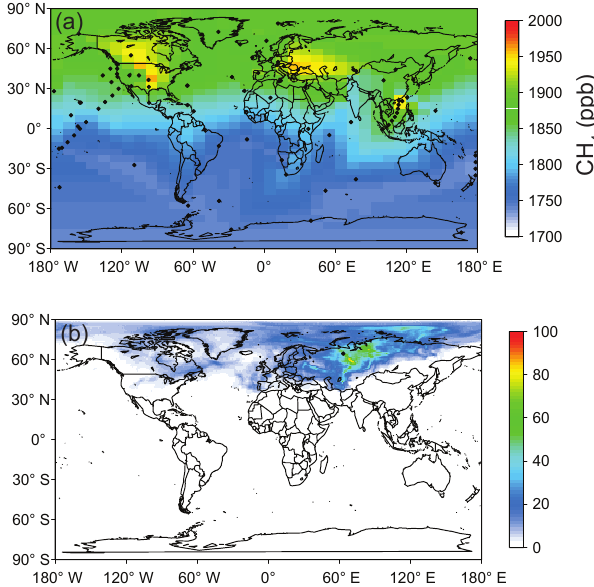
Figure 4. Example of the initial concentration field (units ppb) for January 2009 interpolated from observations in the NOAA network (sites indicated by the black points) (a) and an example shown for site IGR (black dot) of the sensitivity to the initial concentra- tions (percentage) after 10 days backward calculation (mean Jan- uary 2009) (b)